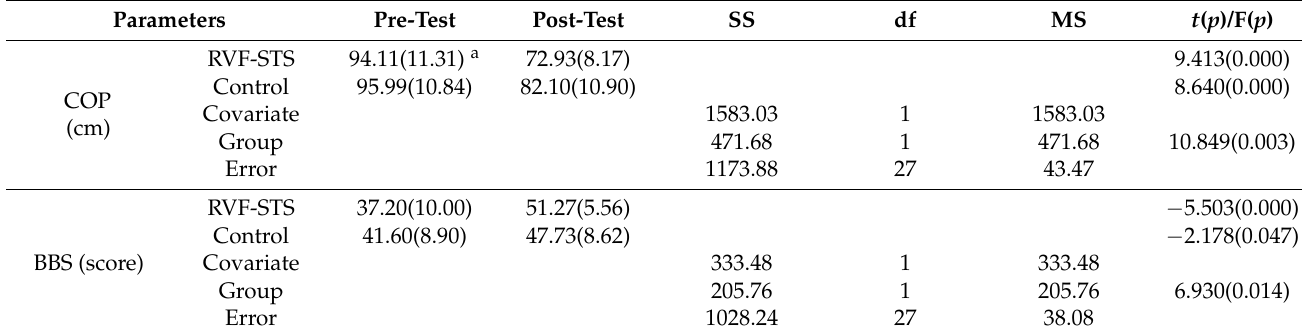
Table 4. Comparison of balance ( N =